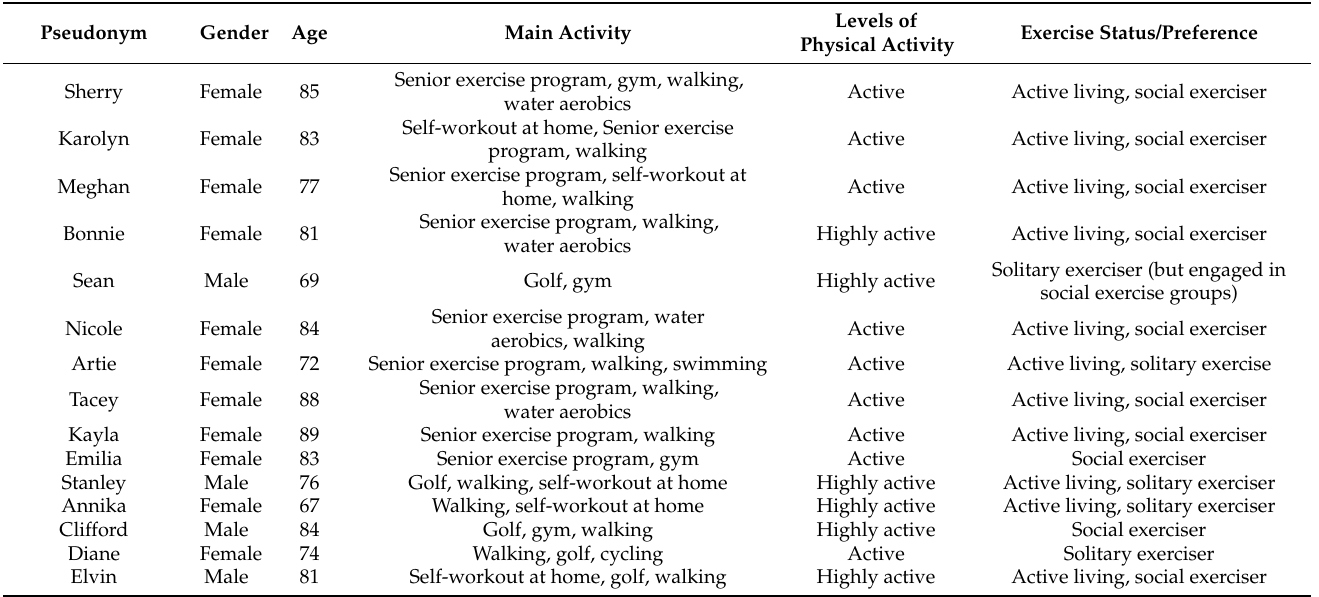
Table 3. Participants’